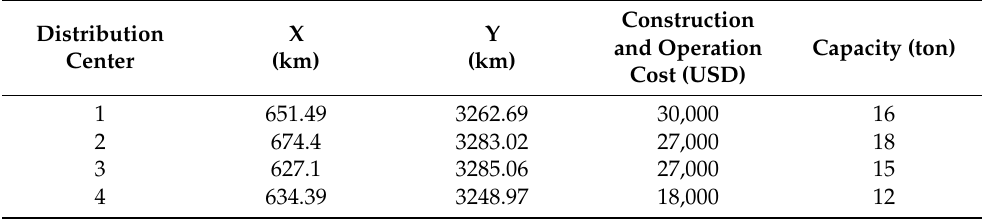
Table 3. Candidate distribution center